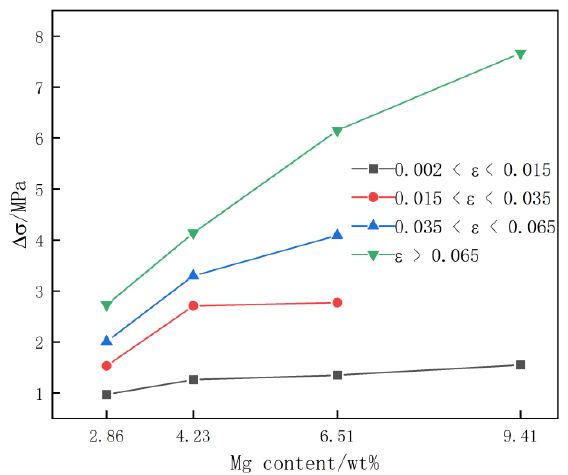
Figure 7. Stress amplitude ∆σ curves of the quenched Al-(2.86~9.41) Mg alloy sheet with increasing Mg